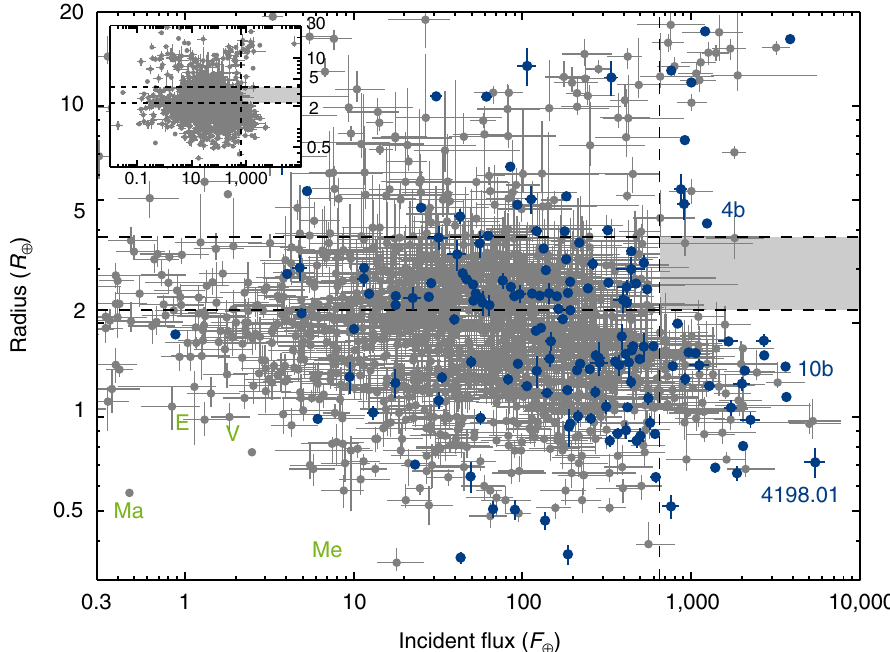
Figure 2 | Radius-flux diagram showing the distribution of exoplanets. The 157 exoplanets in the seismic sample are plotted with 1 s errorbars (in blue), while the non-seismic sample is shown in grey (the inset shows the full non-seismic sample). The exoplanets Kepler-4b, Kepler-10b and KOI-4198.01 are identified in the diagram. The location of the four rocky solar system planets; Mercury (Me), Venus (V), Earth (E) and Mars (M) is indicated with the green writing (no points). The vertical dashed line marks an incident flux of 650 F " , while the horizontal dashed lines indicate radii of 2.2 and 3.8 R " , respectively. The location of the hot-super-Earth desert has been shaded.